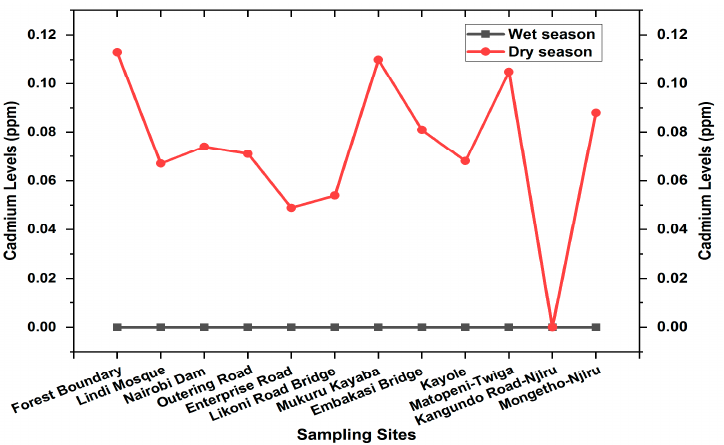
Figure 13. Cadmium (Cd) concentrations in Ngong River measured between April and August 2021. The river recovery capacity (RRC) and the accumulation factor (AF) of the physicochemical parameters during the wet and dry sampling periods are presented in Tables 6 and 7. Table 7. River recovery capacity and accumulation factor for physicochemical parameters of Ngong River dry season.